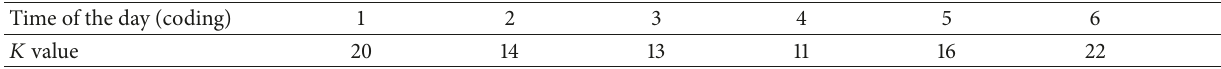
Table 7: Optimal values of 𝐾 .